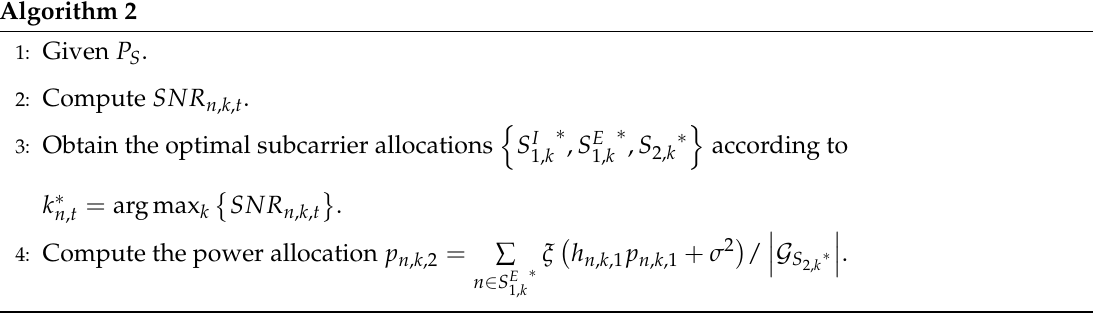
Algorithm 3: The power allocation for relay to forward the S signal in the second timeslot is equally allocated. In the first timeslot, subcarriers are equally allocated to K relays. And in the second timeslot, relays utilized the same subcarriers to forward the S signal.